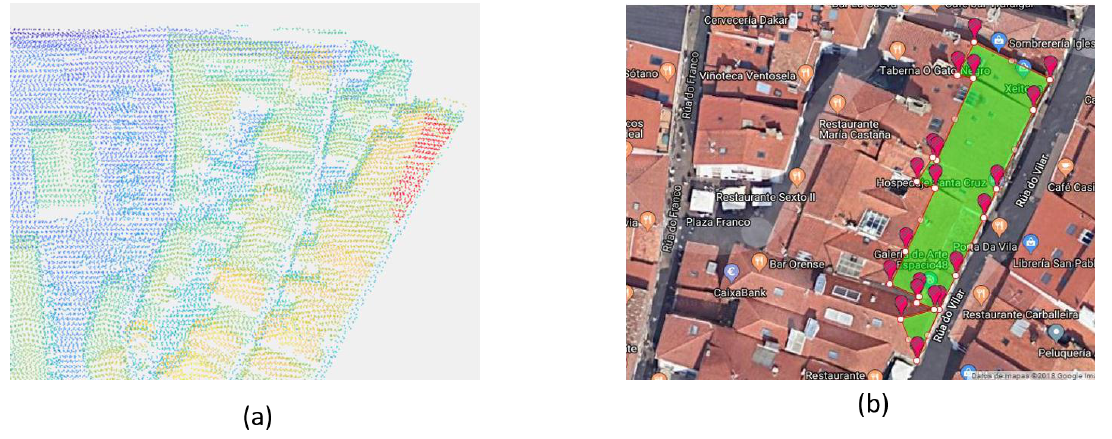
Figure 7. Comparison of measured areas with ground truth areas. ( a ) A cluster of points containing a roof is highlighted in red. Note that it contains only points which are oriented to the South-East, and as there is not physical separation between roofs of different buildings with the same orientation, the cluster presents under-segmentation. ( b ) The manual reference was collected taking into account this nature of the processing algorithms in order to correctly quantify the performance of the methodology.